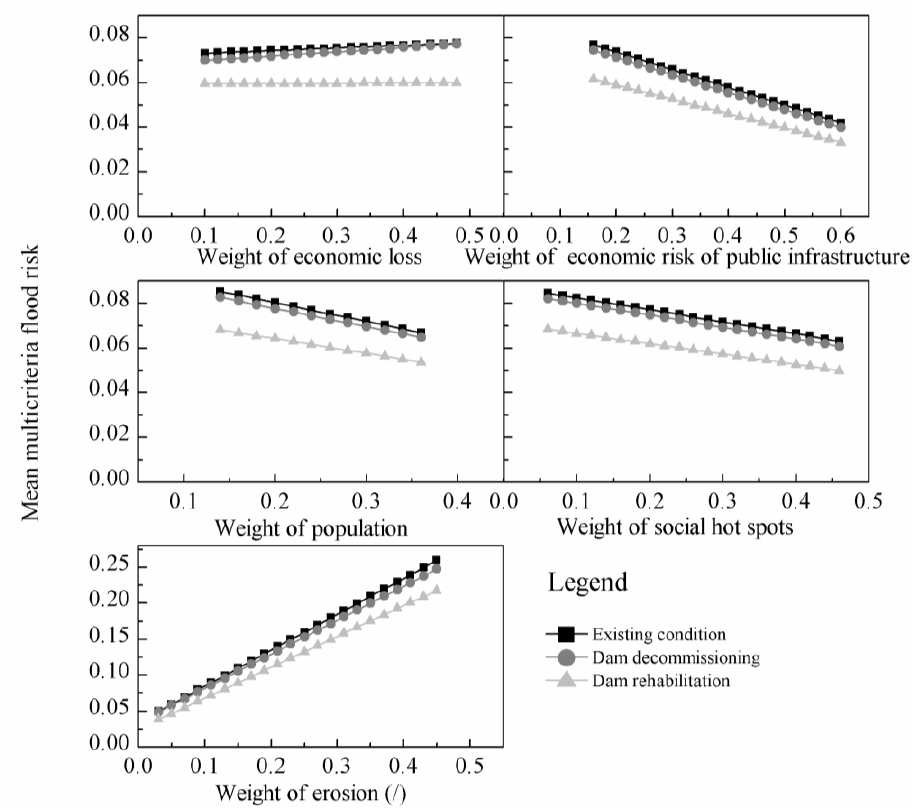
Figure 10. Sensitivity analyses results: the changes of mean multicriteria flood risk for each alternative with an increment (increasing or decreasing by 0.02) of the weight of each individual